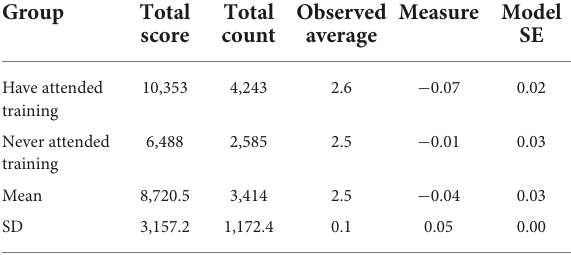
TABLE 8 Teachers’ differences in severity based on training experience.